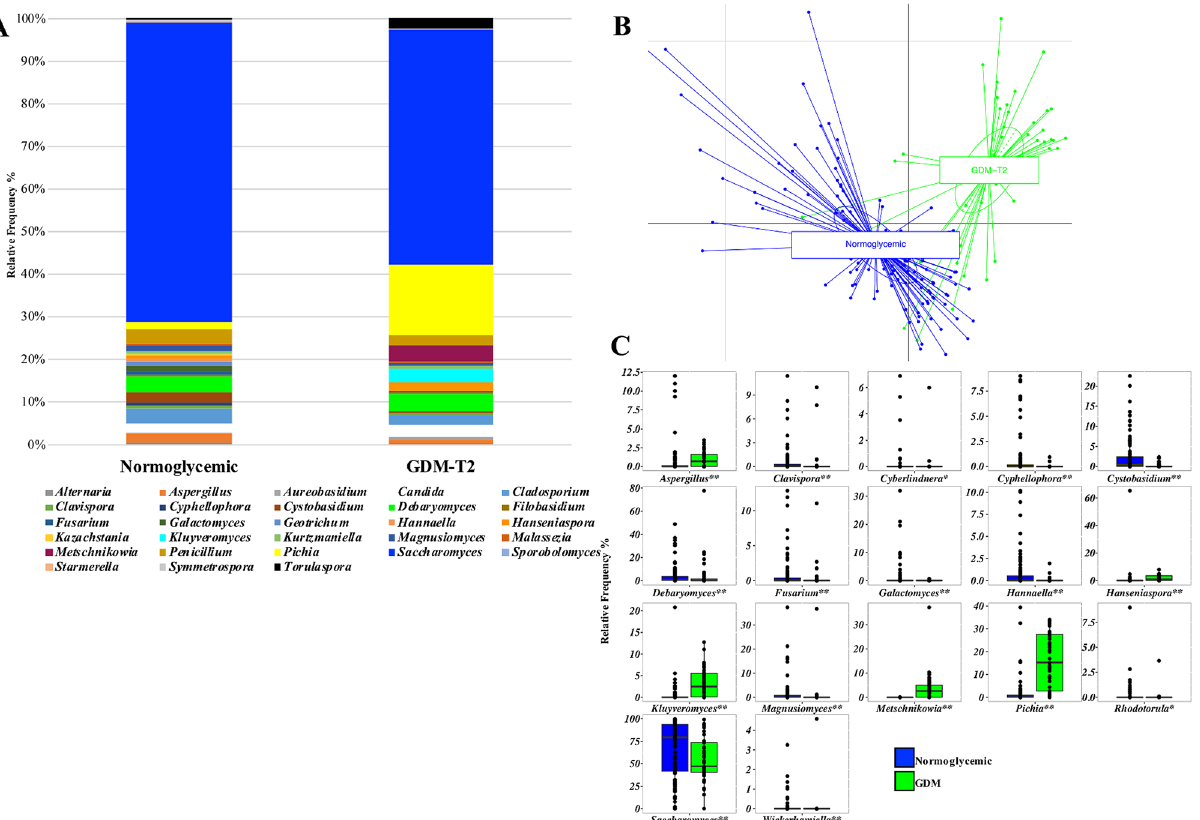
Figure 3. ( A ) global composition of mycobiota at genus level during the second trimester of pregnancy. Only ASVs with a relative frequency > 1% in at least 10 samples are shown. Normoglycemic or GDM subjects are labelled on the x-axis and expressed as the relative Amplicon Sequence Variants (ASVs) frequency. ( B ) Principal Component Analysis (PCA) based on ASVs relative abundance at genus level of normoglycemic and GDM women. ( C ): boxplots of the ASVs at genus level which were significantly different between normoglycemic and GDM women (Mann–Whitney test, * p < 0.05; ** p <